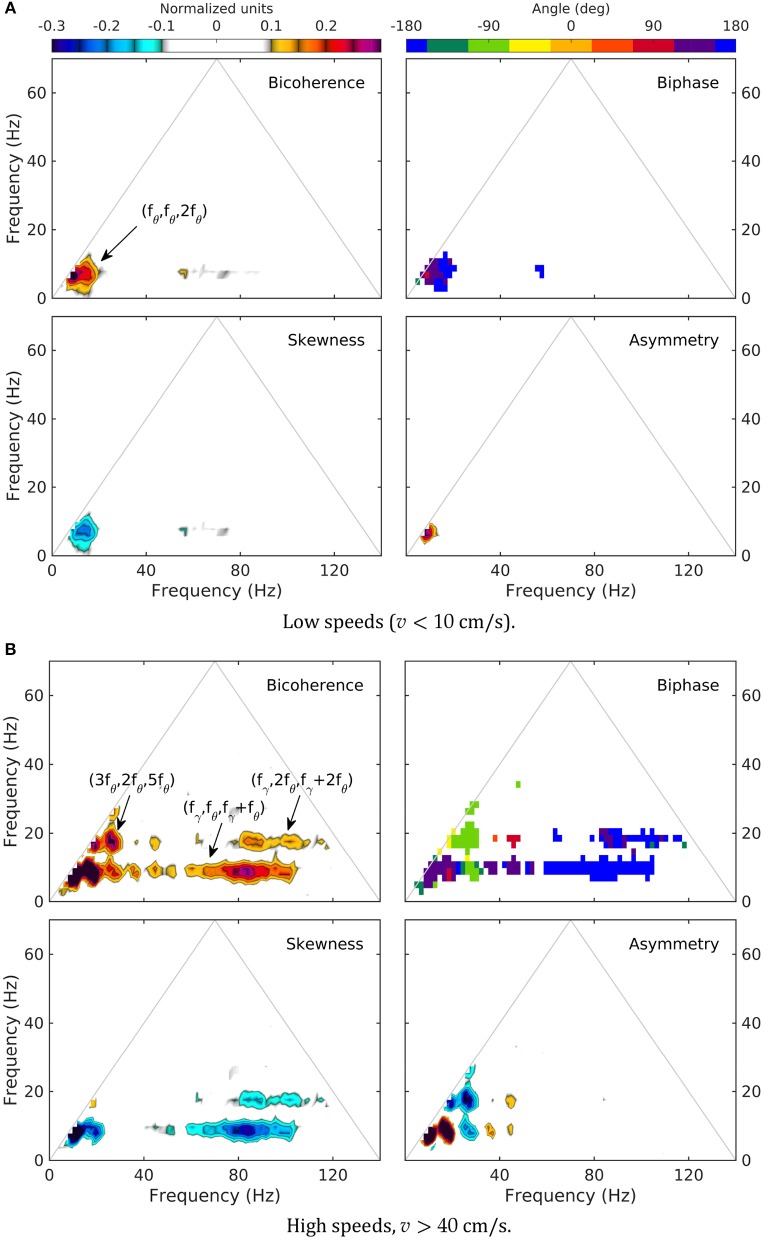
Normalized bispectrum (Equation 5) for the LM layer. The bicoherence is blanked below 0.1 (with 300 DOF, zero-mean bicoherence is < 0.1 at 95% confidence level; Haubrich and MacKenzie, 1965; Elgar and Guza, 1985).